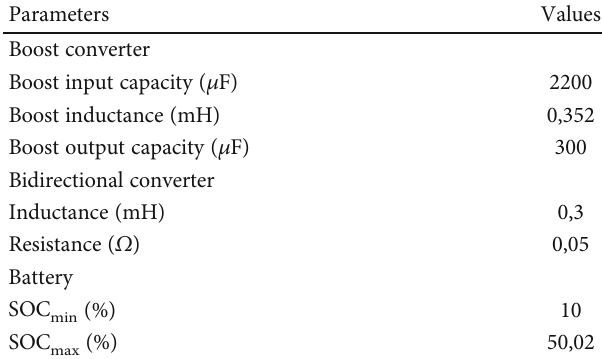
Table 5: Simulation parameters.